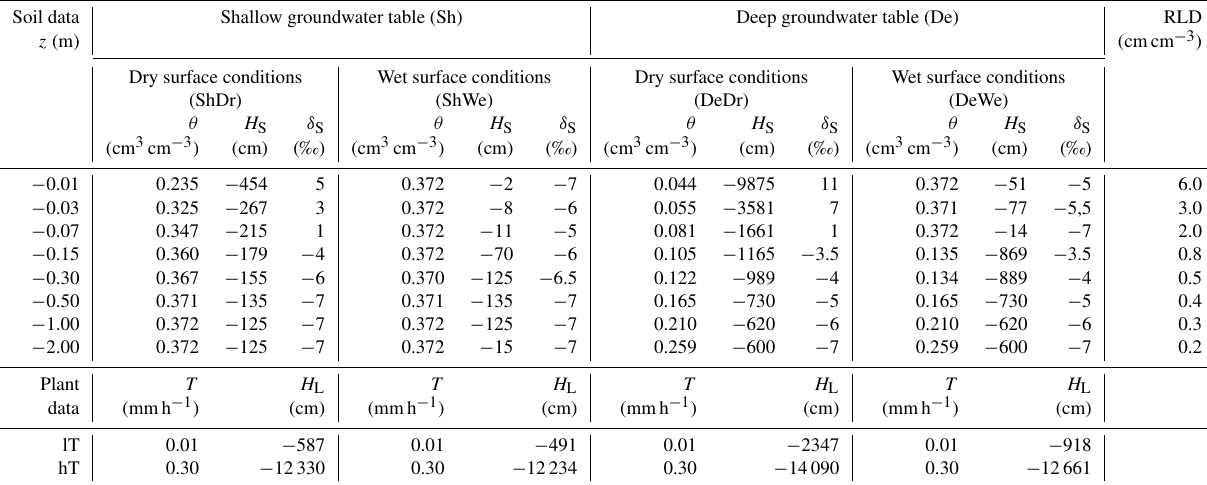
Table 2. Soil, plant, and isotopic synthetic input data for the different modeling approaches (depth ( z) profiles of soil water content θ , total soil water potential H S , soil water oxygen isotopic composition δ S , root length density RLD, transpiration rate T , and leaf water potential H L ) “collected” during eight virtual experiments differing in the depth of the groundwater table (Shallow – Sh/Deep – De) and the water status at the soil surface (Dry – Dr/Wet –